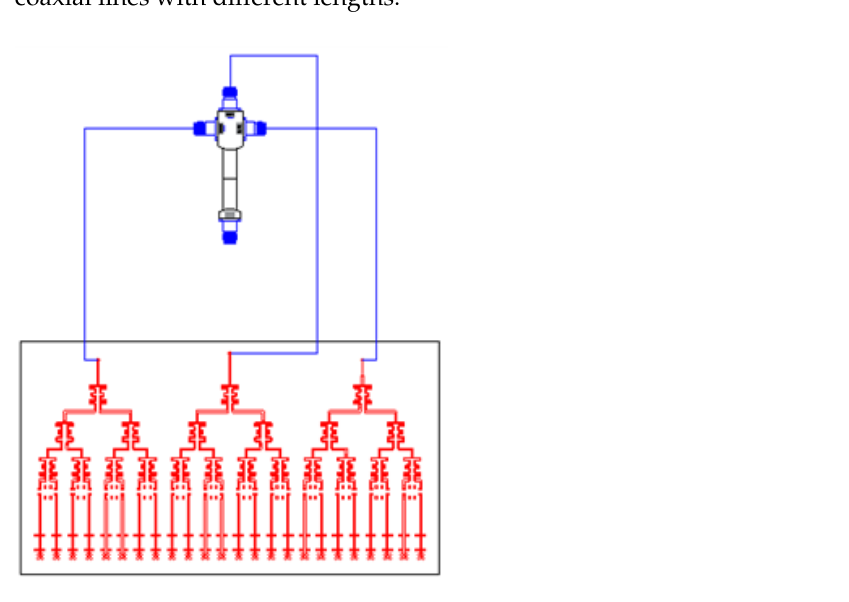
Figure 4. Vivaldi antenna structure diagram.